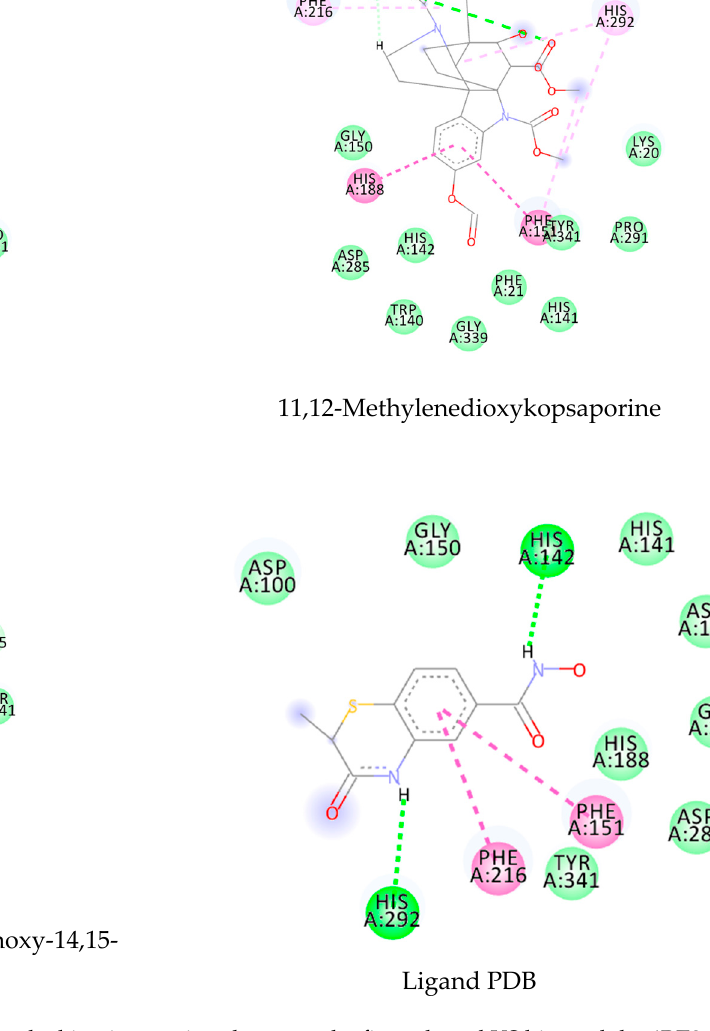
Figure A4. Molecular docking interactions between the five selected VS hits and the 4BZ8 protein. The light green represents the van der Waals interactions, the green represents the conventional H-bonds, and the pink represents the pi-interactions.